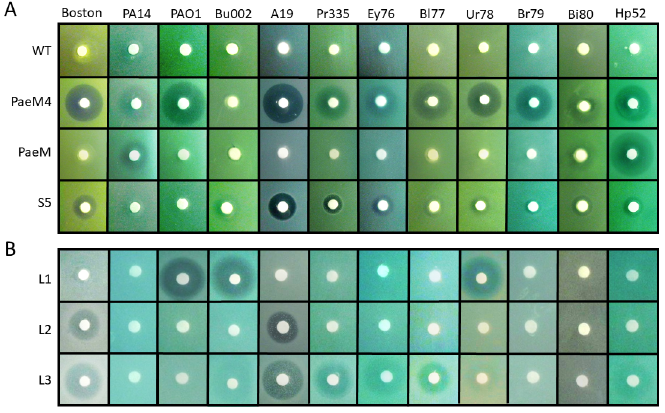
Fig 3. Agar drop plate assay on different P . aeruginosa isolates with plant-produced pyocins. Aliquots of 10 μ l (10 μ g) of purifiedpyocins were spotted on P . aeruginosa agar lawn and incubatedovernight. A– P . aeruginosa agar lawn grown on CAA medium, B– P . aeruginosa agar lawn grown on LB medium.